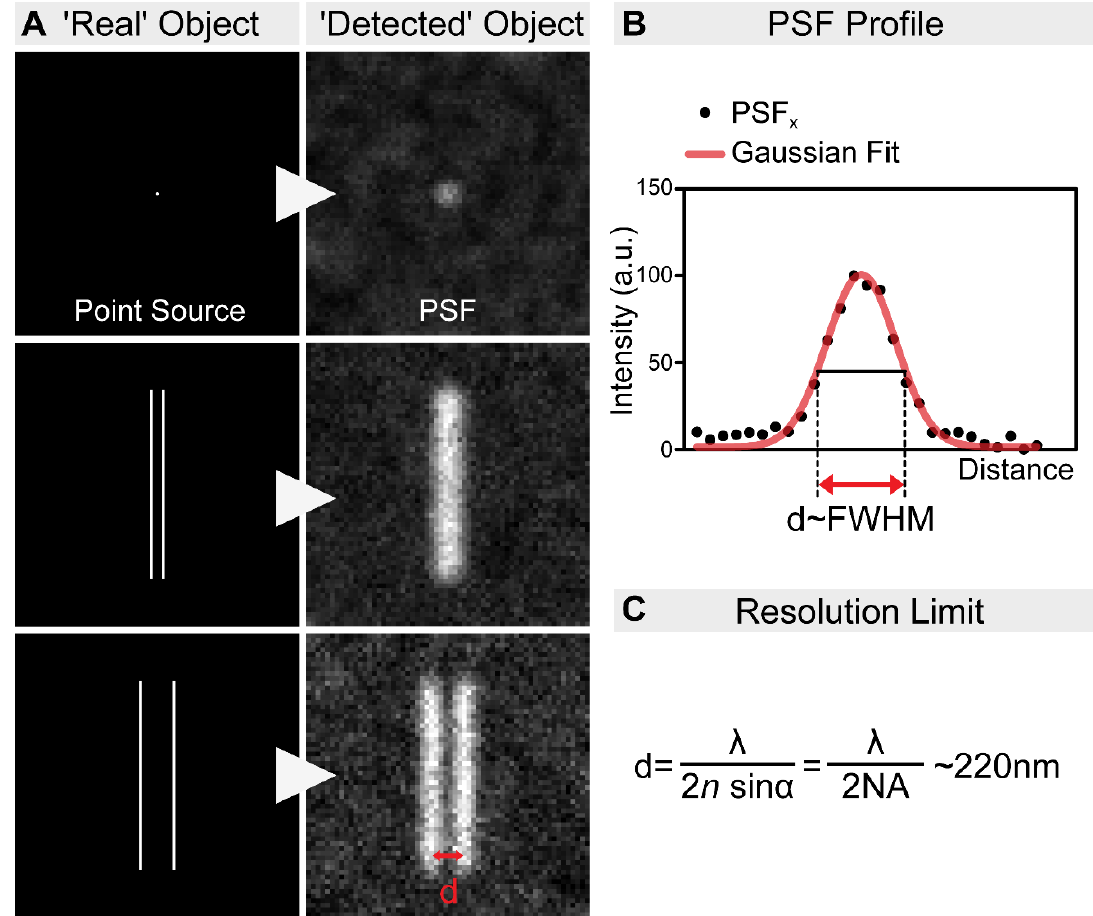
Figure 1. The resolution limit of optical microscopes. ( A ) In practice, even an extremely small point source of light (e.g., a single fluorophore) is still imaged as a spot of finite volume, known as the point spread function (PSF). Therefore, when two objects are close to each other, it is impossible to distinguish them. In order to discriminate them as two individual objects, they need to be separated by an adequate distance (d). This distance, by definition, is the resolution of the microscope. ( B ) The resolution of an optical system can be estimated by measuring the full-width at half-maximum (FWHM) of the PSF. ( C ) The spatial resolution of an optical imaging system is limited by the diffraction of the light, which was first described in 1873 by Ernst Abbe. This resolution limit in microscopy is calculated by the following equation: λ/2NA, where λ is the wavelength of the light, and NA is the numerical aperture of the objective. Accordingly, even in the most favorable condition, with a high NA objective and the lowest possible wavelength, the resolution will never be higher than ~220 nm.